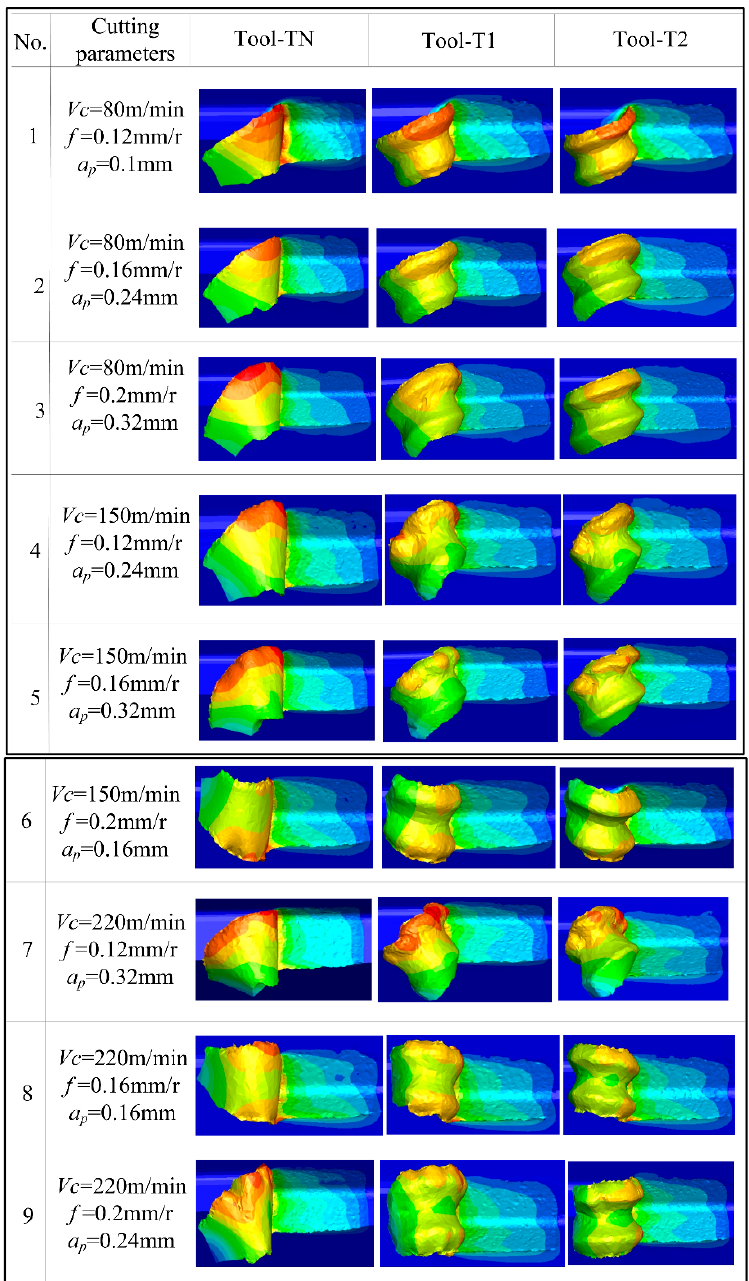
Figure 6. Chip morphology of different curved tools under different cutting parameters.